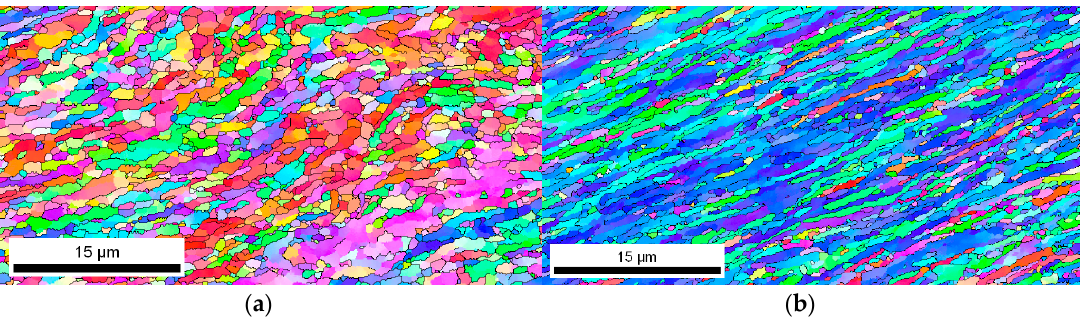
Figure 5. EBSD texture maps for ( a ) sample subjected to a low temperature pre-annealing after 16 CCDF passes and ( b ) sample subjected to a high temperature pre-annealing after 24 CCDF passes.